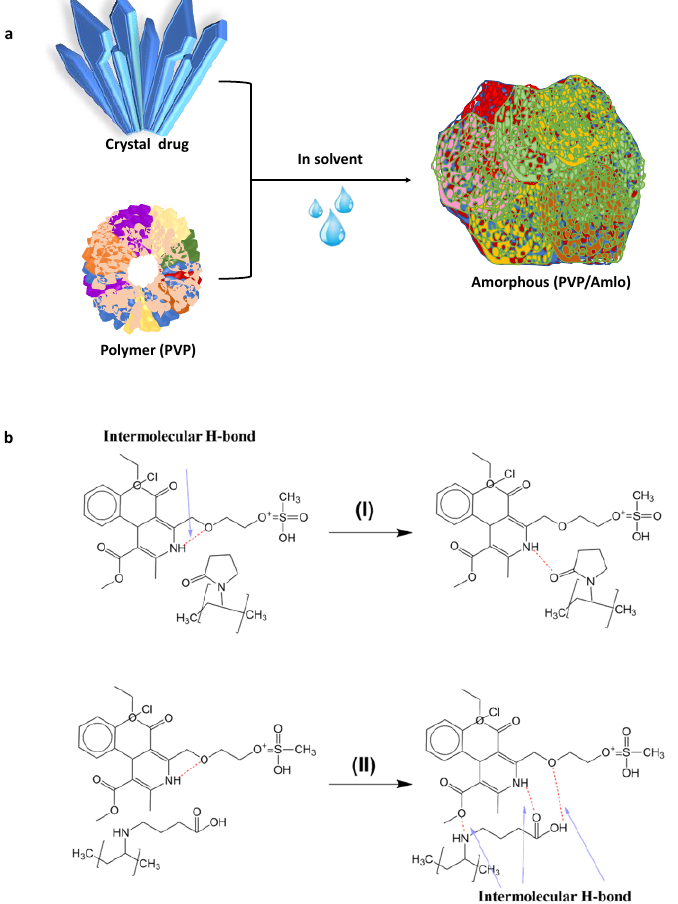
Figure 7. The schematic illustration of ( a ) hydrophilic and hydrophobic sides of the amlodipine besylate. ( b ) System of amorphous solid dispersion. Formation mechanism of drug – drug (I) and drug – polymer (II) intramolecular and intermolecular hydrogen bonding, respectively. H bonds are shown as red lines. Adapted from data presented originally in Ref [70].